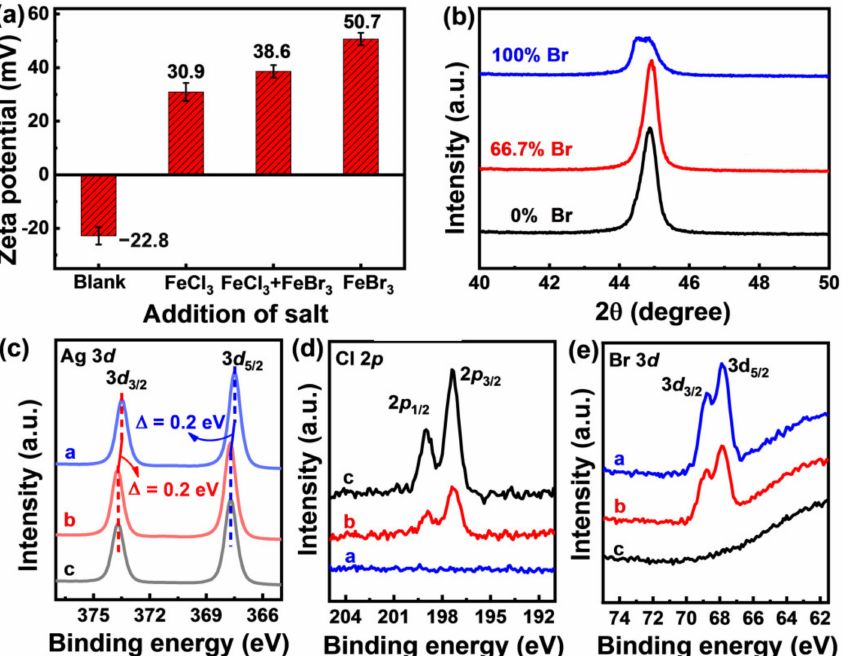
Figure 4. ( a ) Zeta potential of as-synthesized AgNWs in different solutions. Equal amount of halogen ions are added in FeCl 3 solution, FeCl 3 –FeBr 3 mixed solution, and FeBr 3 solution; ( b ) XRD pattern of as-synthesized AgNWs. The high-resolution XPS regions of Ag 3 d ( c ), Cl 2 p ( d ), and Br 3 d ( e ) for AgNWs synthesized at different halogen compositions: the blue line, red line, and black line represent the synthesis conditions of 100% Br − , 66.7% Br − , and 0% Br − ,